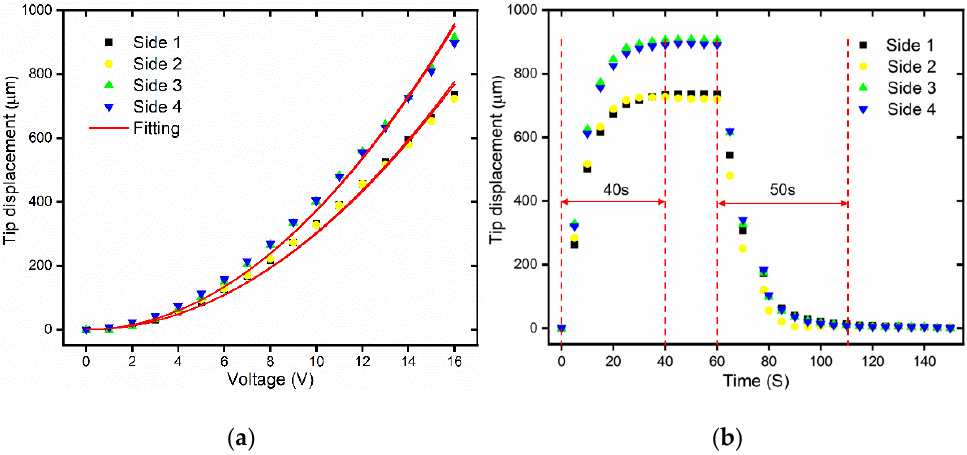
Figure 9. The static and dynamic testing of the 3D U-shaped actuator. ( a ) The static displacements vs. voltages; ( b ) The dynamic displacement under a voltage of 16 V.